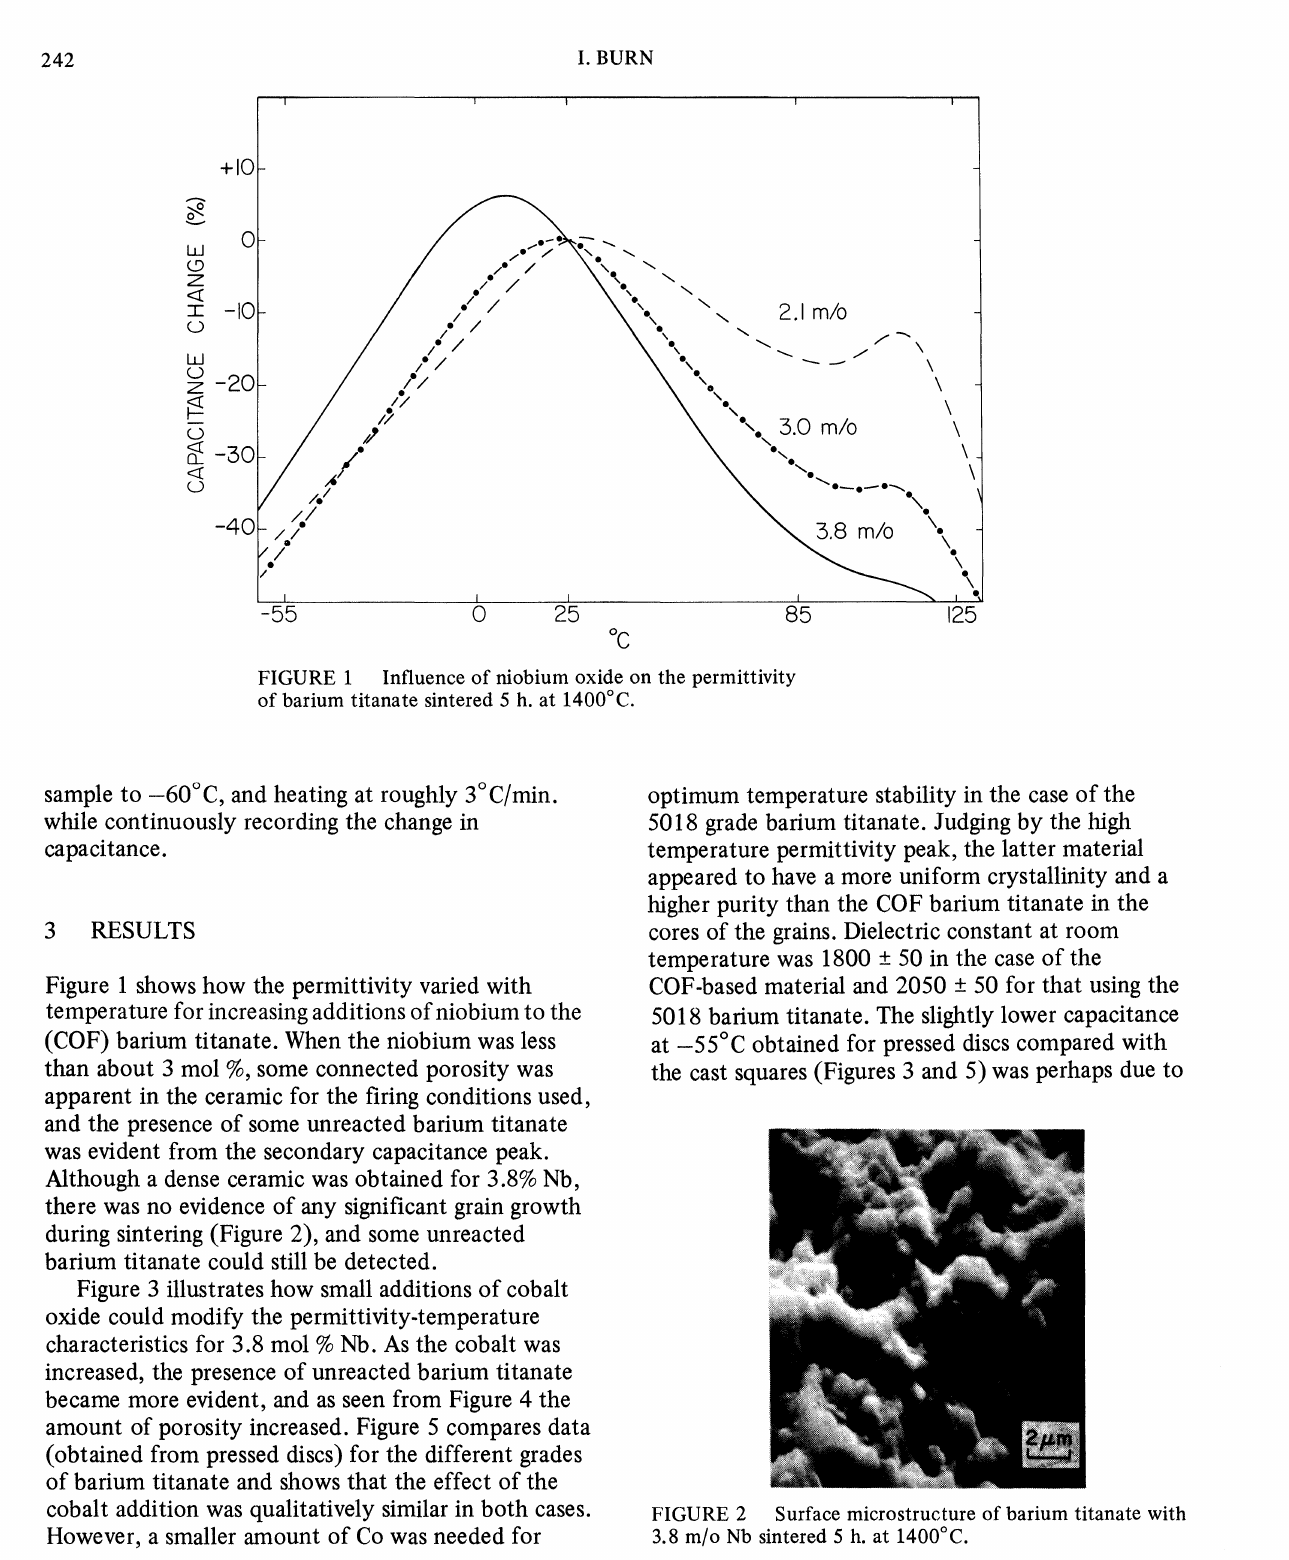
Surface microstructure of barium titanate with 3.8 m/o Nb sintered 5 h. at